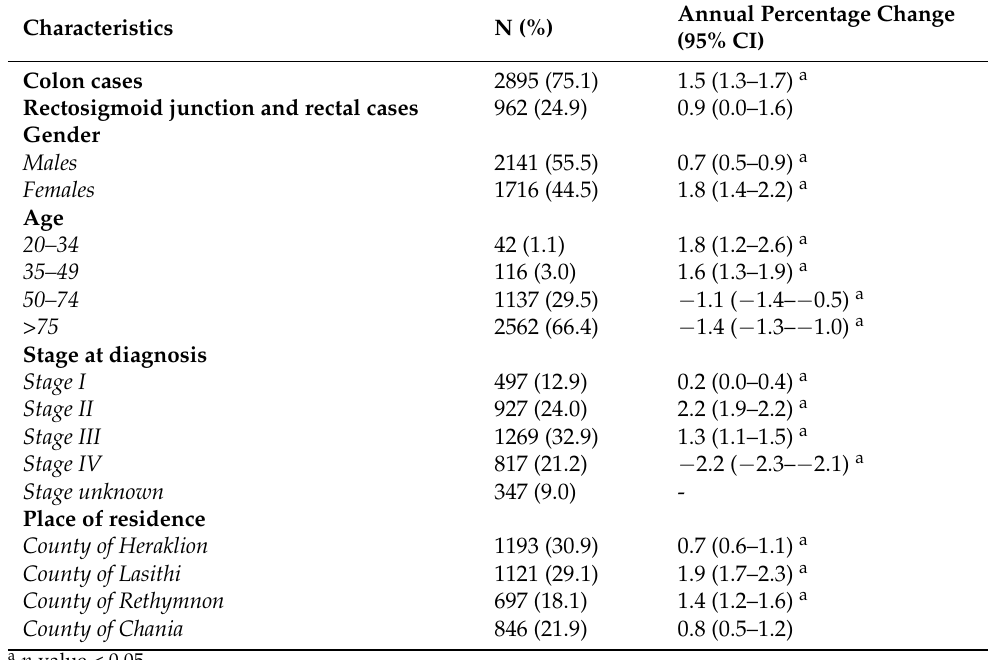
Table 1. Characteristics of the study sample and annual percentage change of the ASIR (age- standardized incidence rates).